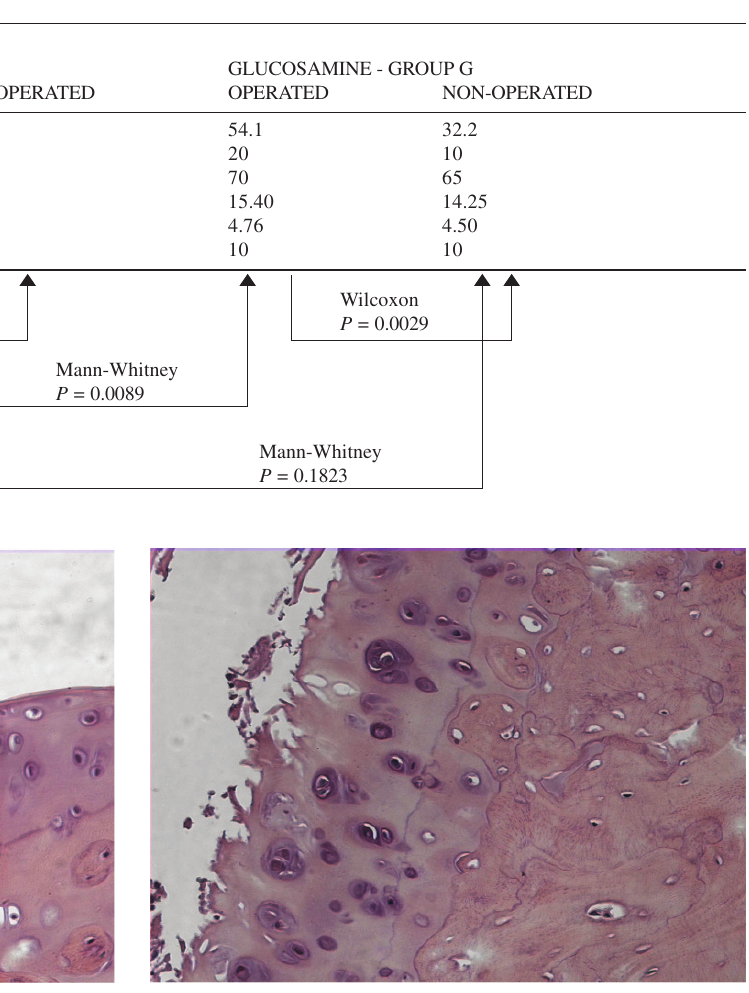
Table 2 - Evaluation of knee extension level, with 0 degrees corresponding to maximum